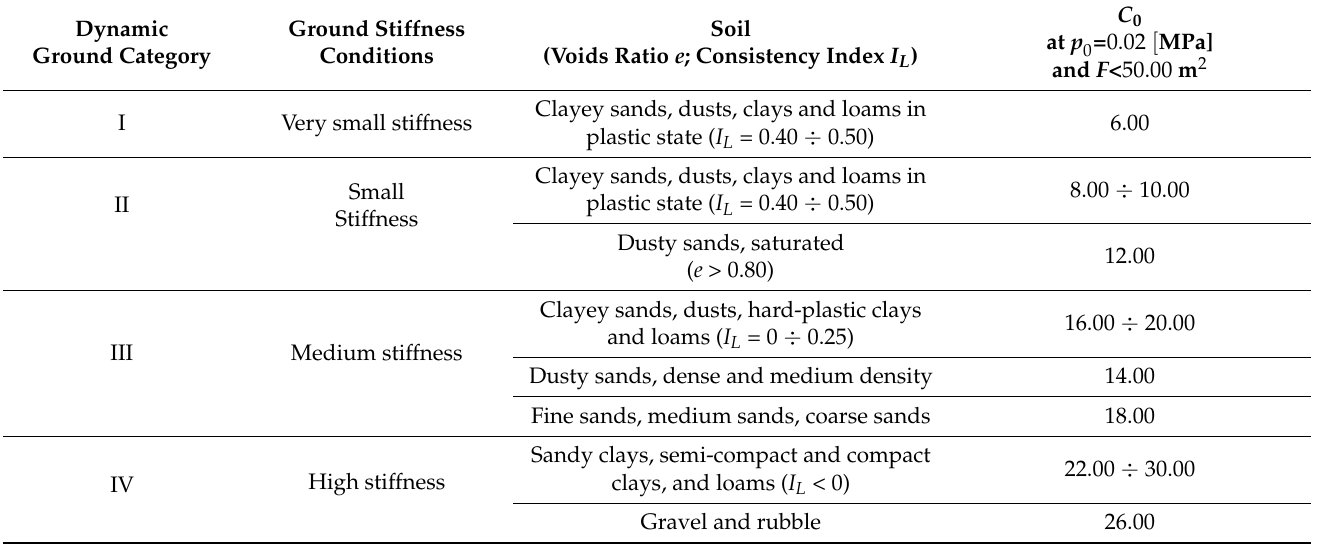
Table 2. Savinov method [38]: suggested values for C 0